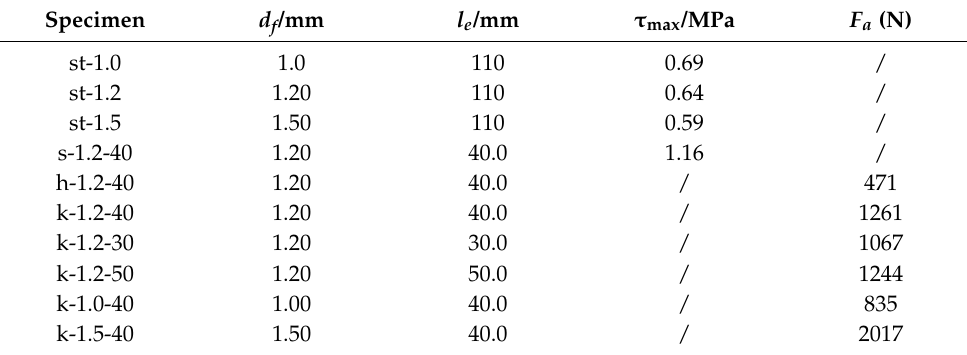
Table 5. Calculated parameters of the bond-bearing capacity of test specimens. Specimen d f